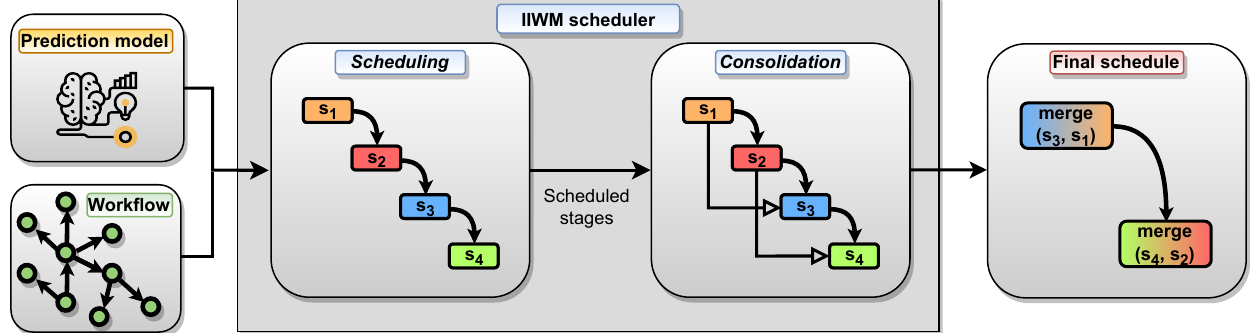
Figure 3. Execution flow of the IIWM scheduler. Given a workflow and a prediction model as the input, a scheduling plan is generated in two steps: (i) building of the stages and task assignment; (ii) stage